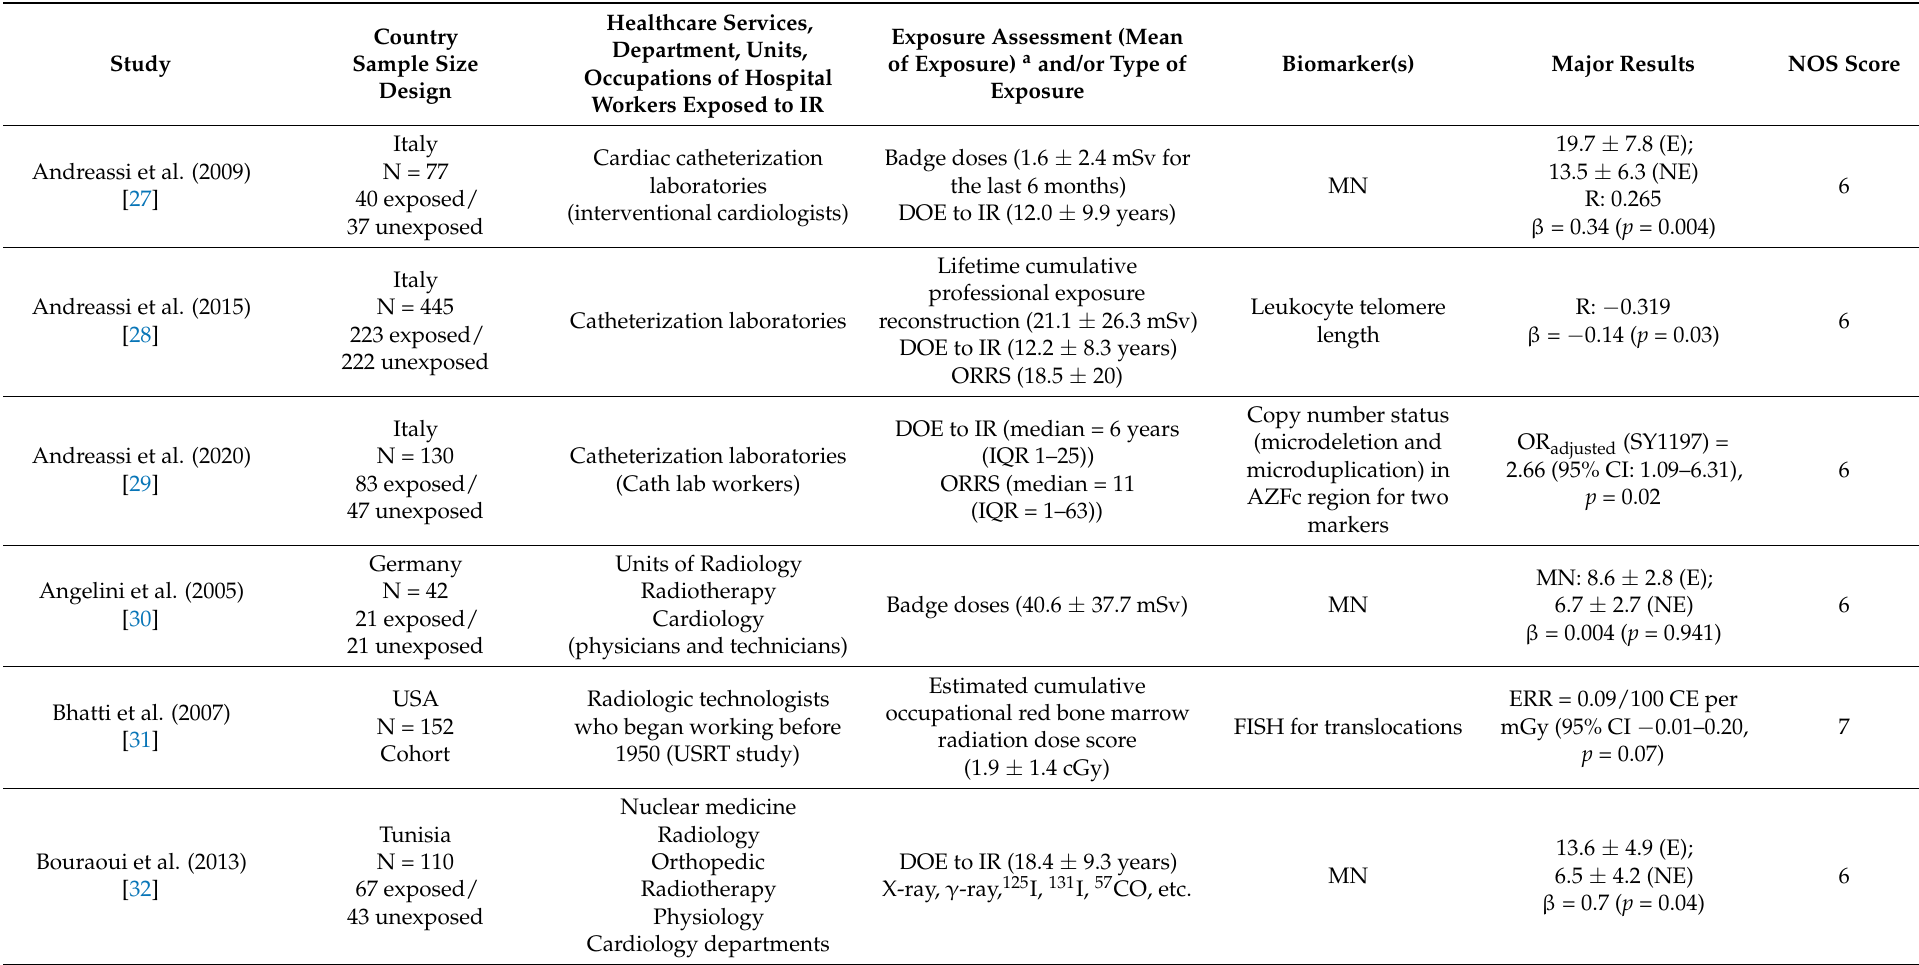
Table 2. List and characteristics of the included